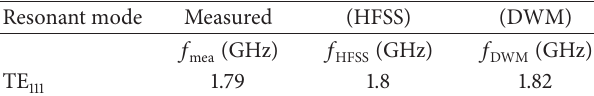
Table 2: Comparison of resonant